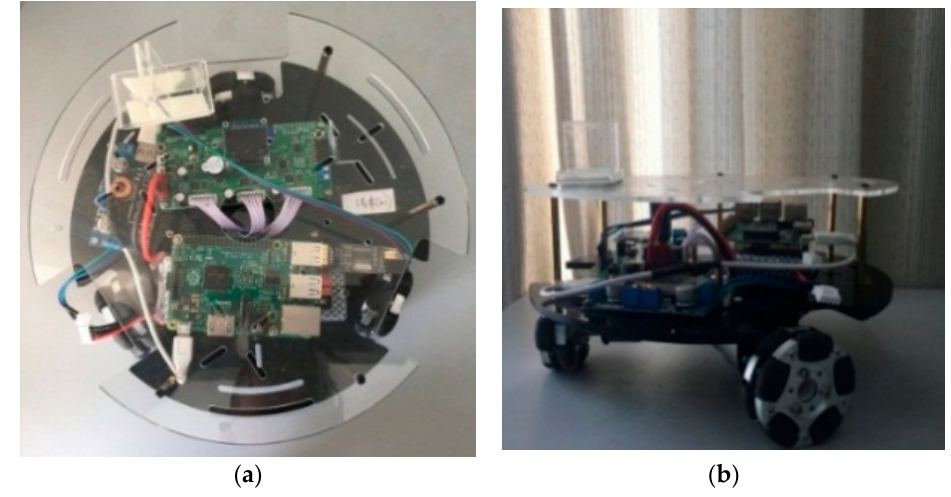
Figure 8. Omnidirectional robots. ( a ) Top view; ( b ) Side view.